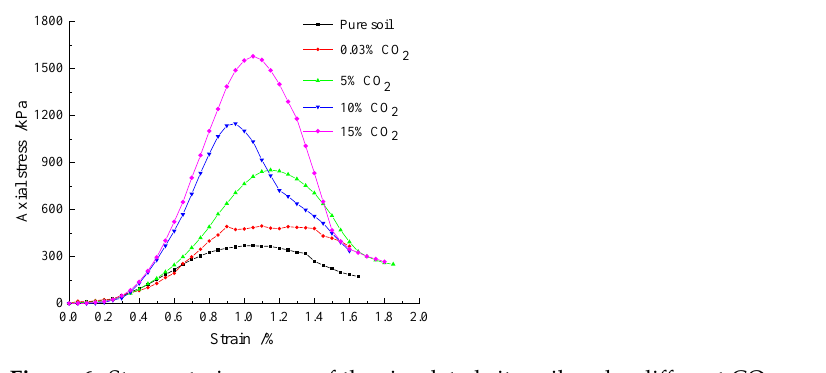
Figure 6. Stress – strain curves of the simulated site soil under different CO 2 concentration curing conditions. Figure 7. ( a ) Stress – strain curve of the simulated site soil with curing under 5% CO 2 concentration. ( b ) Stress – strain curve of the simulated site soil with curing under 10% CO 2 concentration. ( c ) Stress – strain curve of the simulated site soil with curing under 15% CO 2 concentration.